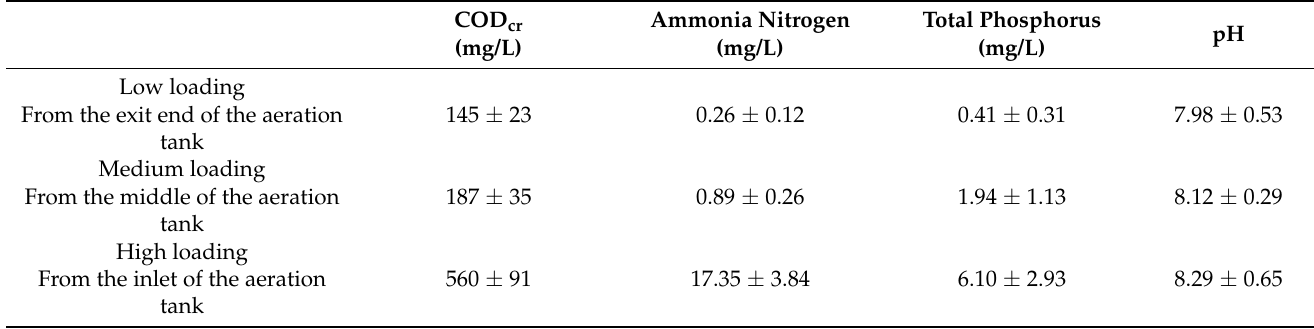
Table 1. Water quality of the influent of pilot-scale